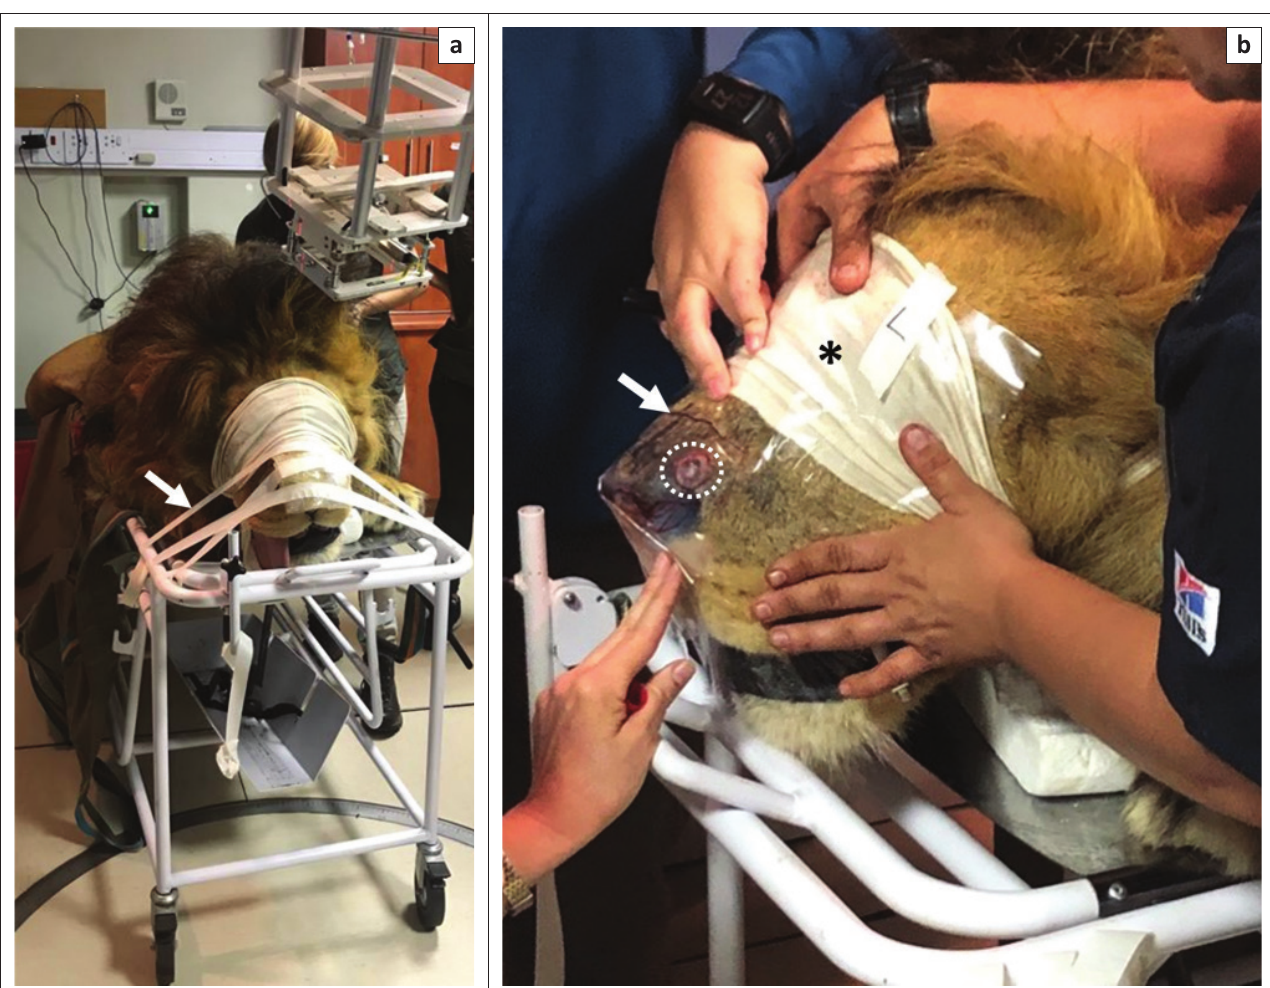
FIGURE 3: Photograph of the lion being prepared for radiotherapy treatment. (a) Lion strapped onto a patient trolley in the prone position, with the head secured with tape ( arrow ) to prevent movement. (b) Blindfold applied for protection of the eyes ( asterisk ) and Elasto-Gel applied and marked for correct positioning ( arrow ) to ensure the correct dose of radiation was uniformly delivered to the affected area of the nasal planum ( dashed circle